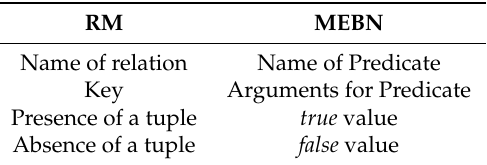
Table 2. Predicate Mapping in